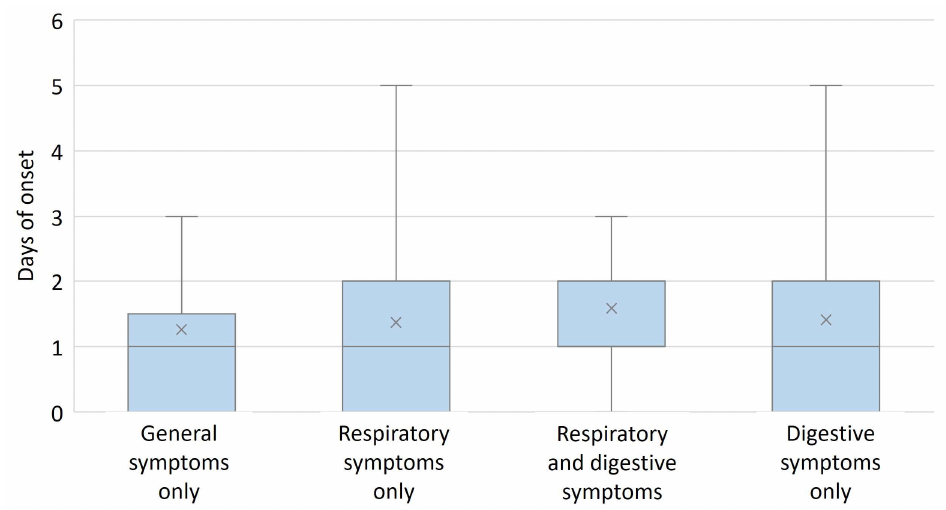
Figure 4. Number of days since onset of symptoms according to type of symptoms. The presence of general symptoms only (no digestive or respiratory symptoms) led to an earlier hospital presentation among infants. Box and whiskers plot represent the 25 th and 75 th percentiles (box), the median (×x) and the range (whiskers).